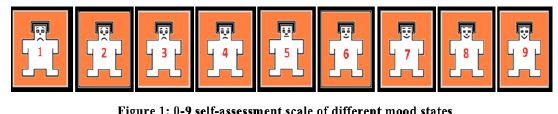
Table 1: Anthropometric and cardiac variables of subjects